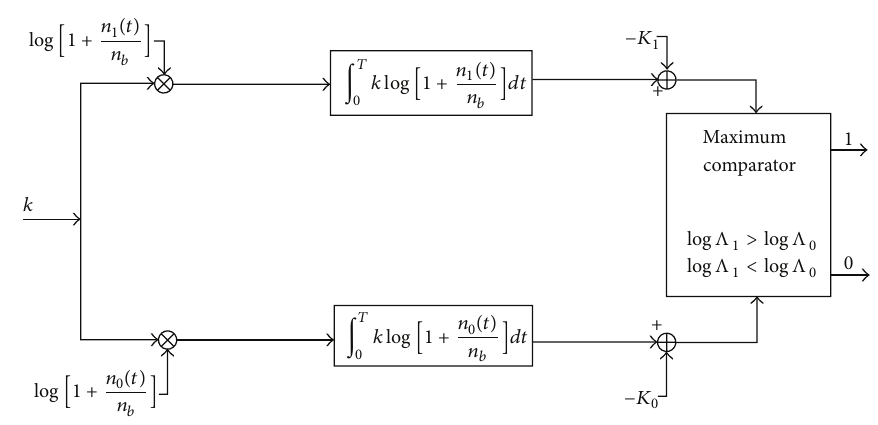
Figure 2: Integrated version of Poisson